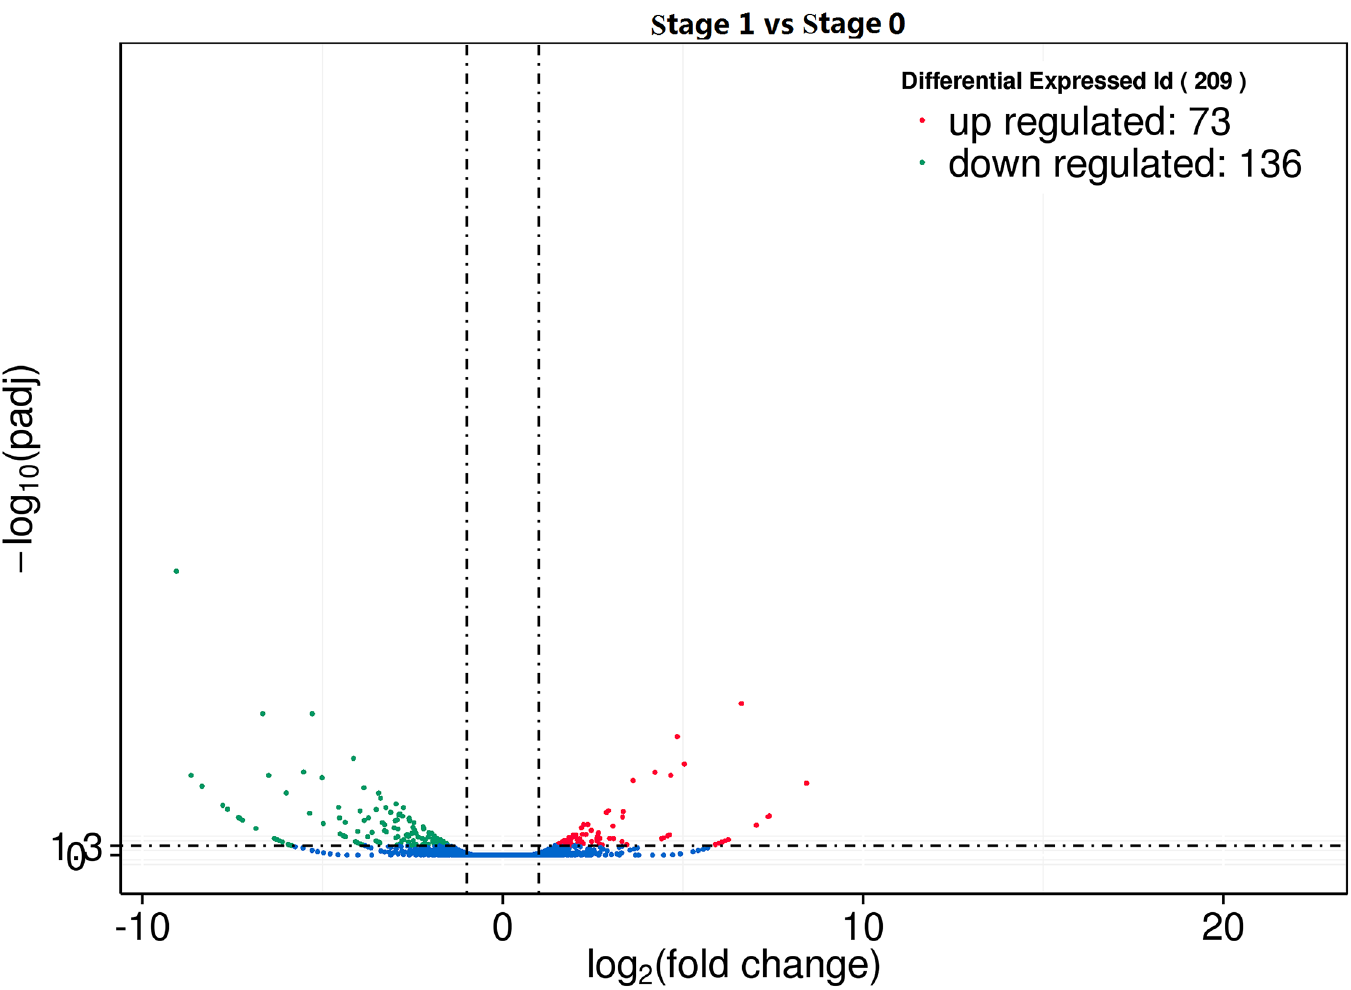
Fig 5. Differentially expressed genes and lncRNAs in sheep skin between stage 0 and stage 1 of secondary HF morphogenesis. Of the 209 differentially expressed genes and LncRNA, 73 were upregulated (right, red) and 136 were downregulated (left, green) in stage 1 compared with stage